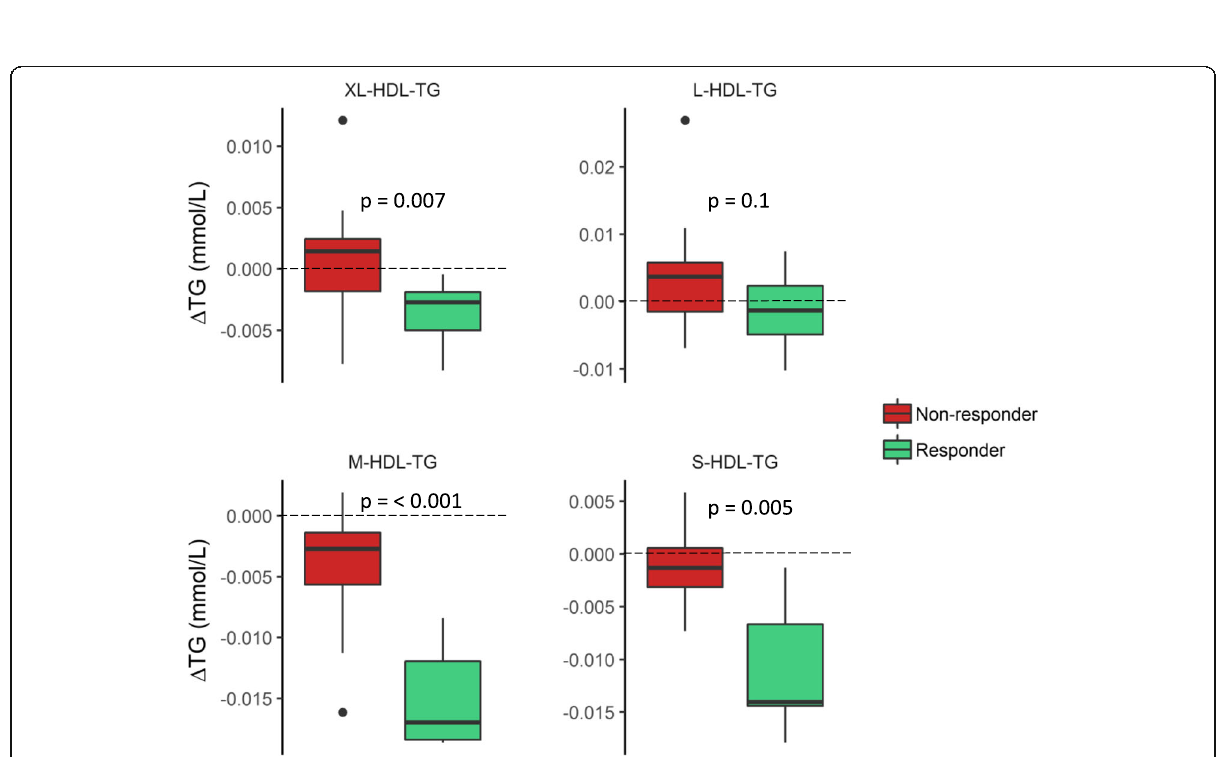
Fig. 4 Change in triglyceride levels in HDL subclasses. The change in TG levels in XL-, L-, M-, and S-HDL subclasses from baseline to the end of study ( Δ mmol/L) in responders (green) and non-responders (red). Differences are tested on the log 2 ratio with an independent t